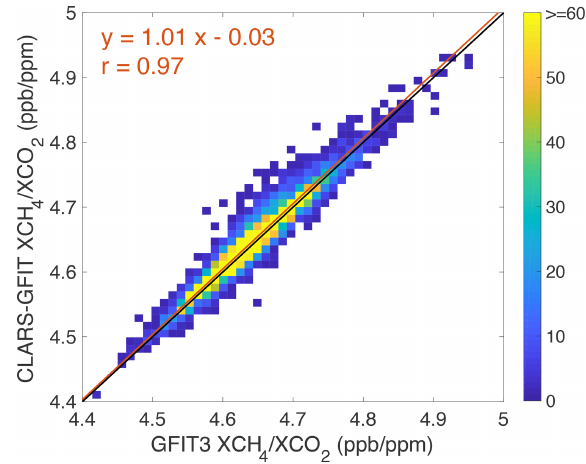
Figure 17. Scatter plot of the XCH 4 / XCO 2 ratio from GFIT3 and CLARS-GFIT. The 1 : 1 line is shown in black. The red line denotes the best fit using type II linear regression to fit the data. The equation for the regression fit is also